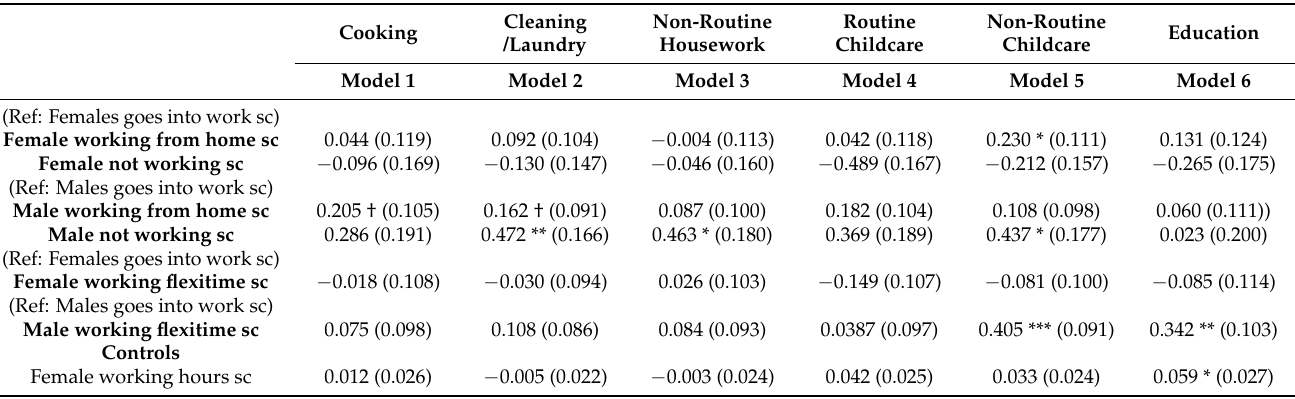
Table A3. Model explaining the changes in the amount of housework and childcare men carried out during the COVID-19 lockdown compared to before the lockdown for heterosexual dual earning couples with children under 18 (female respondents’ perception of their partners’